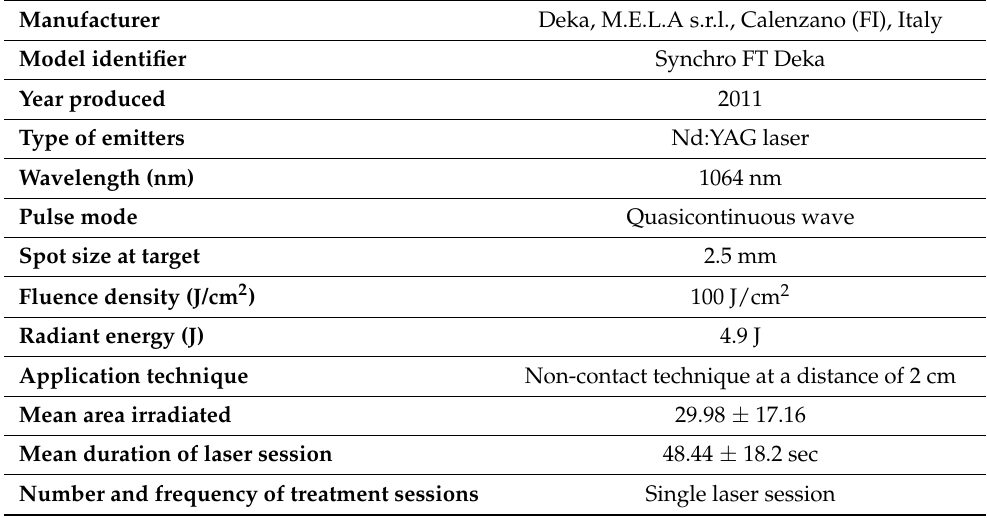
Table 5. Characteristics of the Nd:YAG laser device and operative parameters of the protocol used. Manufacturer